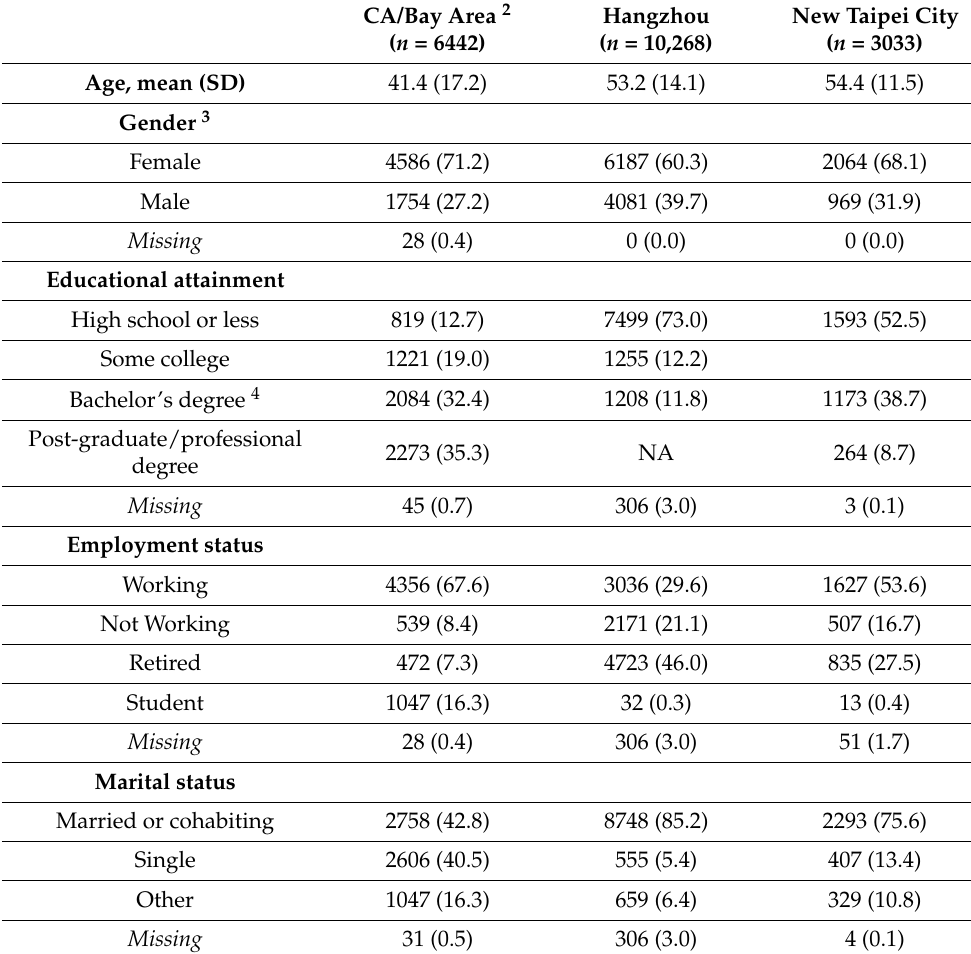
Table 2. Demographic Characteristics of Study Participants 1